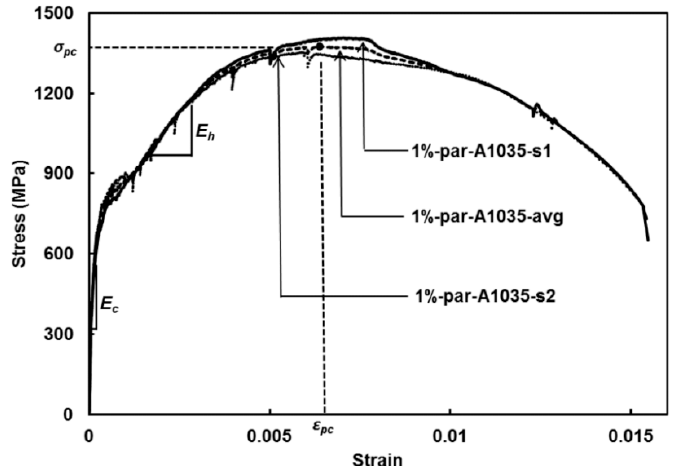
Figure 16. Typical variation of stress versus strain response of one test series.